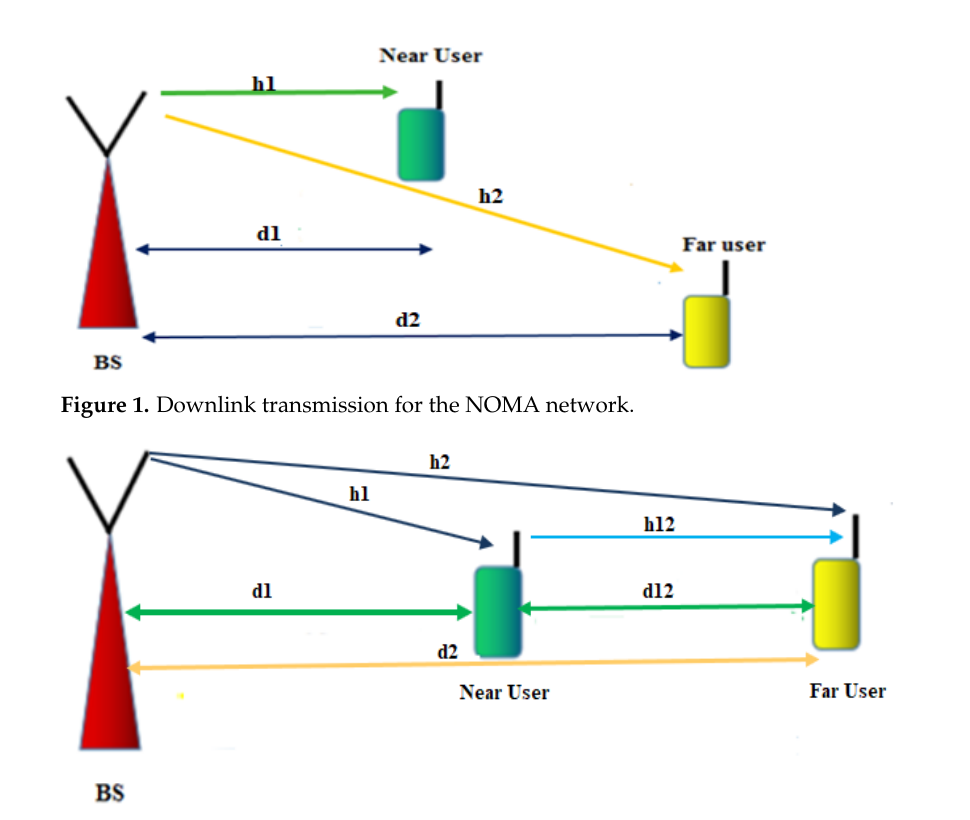
Figure 2. Downlink transmission for the cooperative NOMA network.